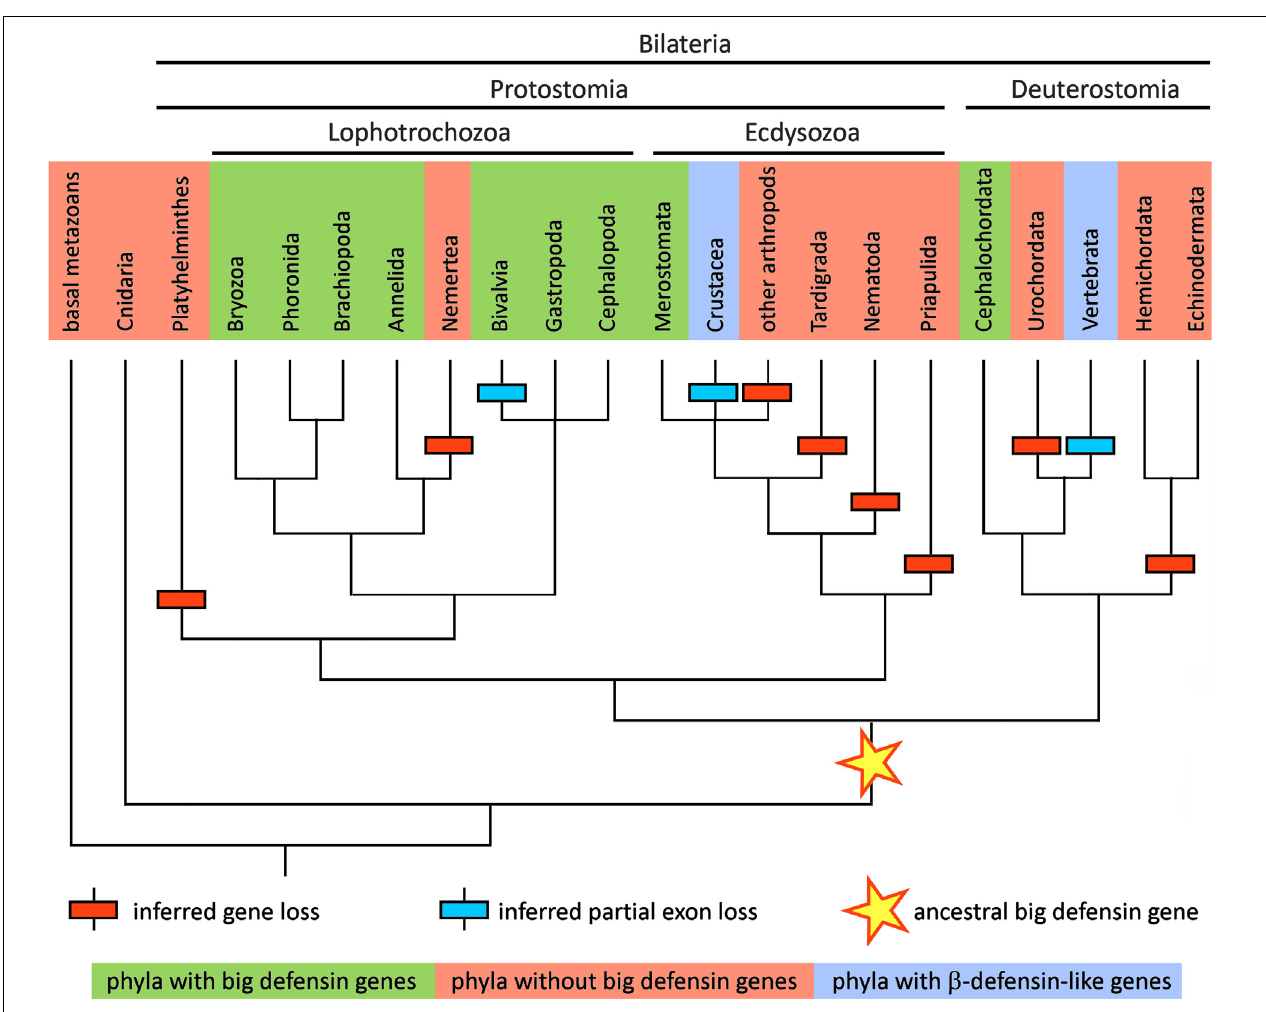
FIGURE 3 | Schematic representation of the metazoan tree of life, reporting the presence of big defensins in all the major phyla relevant in the context of this study. The topology of the tree follows the branching pattern resulting from a recent phylogenomic study (100). Taxa where big defensins have been reported are marked with a green background and those where big defensins are absent are marked with a red background. Taxa where no big defensins are present, but β -defensin-like peptides have been reported, are indicated with a light blue background. The hypothetical origin of the primordial big defensin gene is shown with a star. Inferred big defensin gene loss events are indicated with a red box and inferred partial exon loss events are indicated with a blue